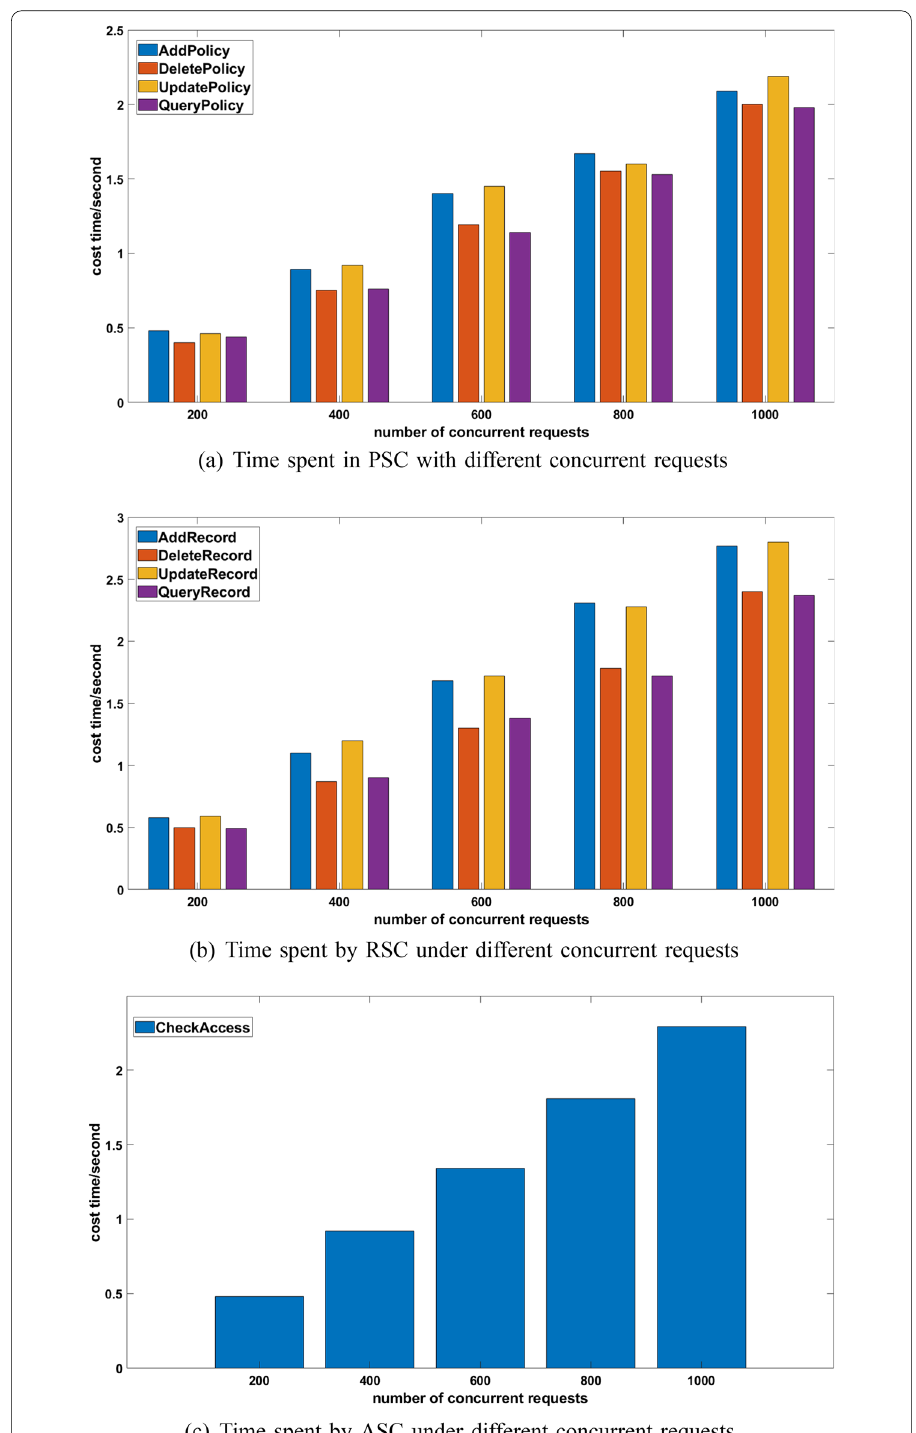
Fig. 14 Time spent on different concurrent